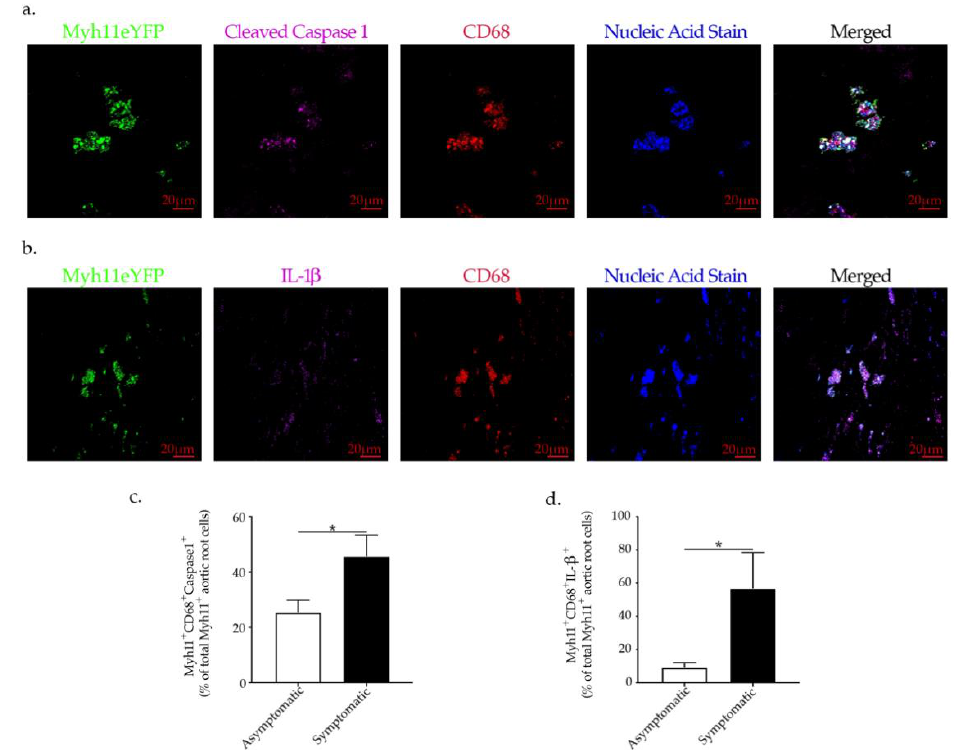
Figure 8. Representative immunofluorescence staining of Myh11 + cells, expressing ( a ) cleaved caspase 1, CD68 and ( b ) IL-1β, CD68 in human atherosclerotic plaques associated with NLRP3-inflammasome activation in VSMC and linked to plaque rupture in human carotid artery disease shown by confocal microscopy. Graph bars show the mean ± SEM of ( c ) Myh11 + CD68 + cleaved caspase 1 + and ( d ) Myh11 + CD68 + IL-1β + co-expressing cells as a percentage of plaque Myh11 cells + cells with n = 12/group and * p < 0.05, unpaired t -test.